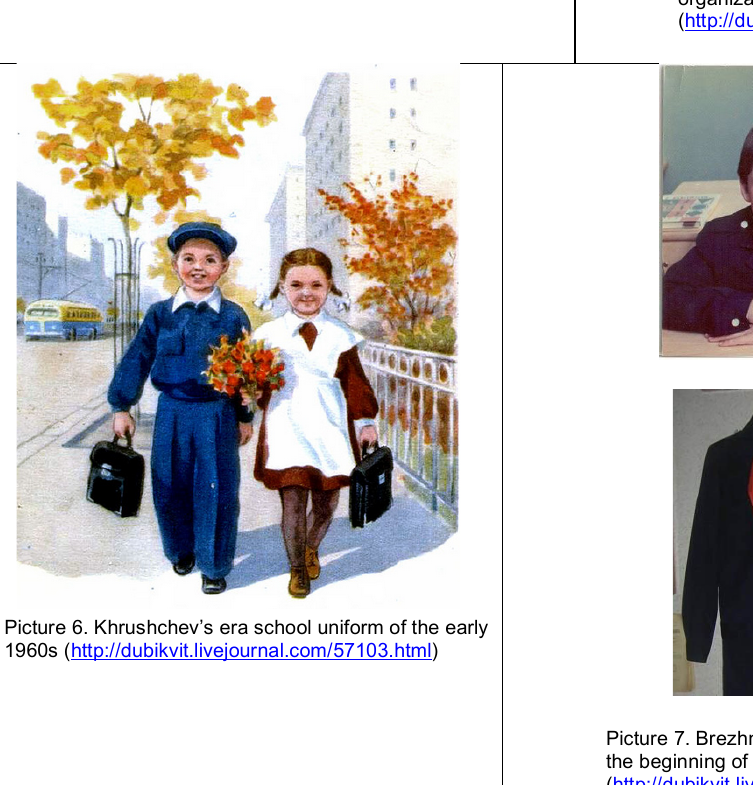
Picture 4. School uniform in tsarist schools before 1917 (http://dubikvit.livejournal.com/57103.html)